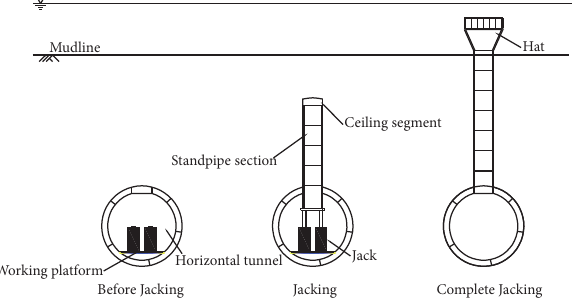
Figure 1: Construction process of the vertical tunnelling